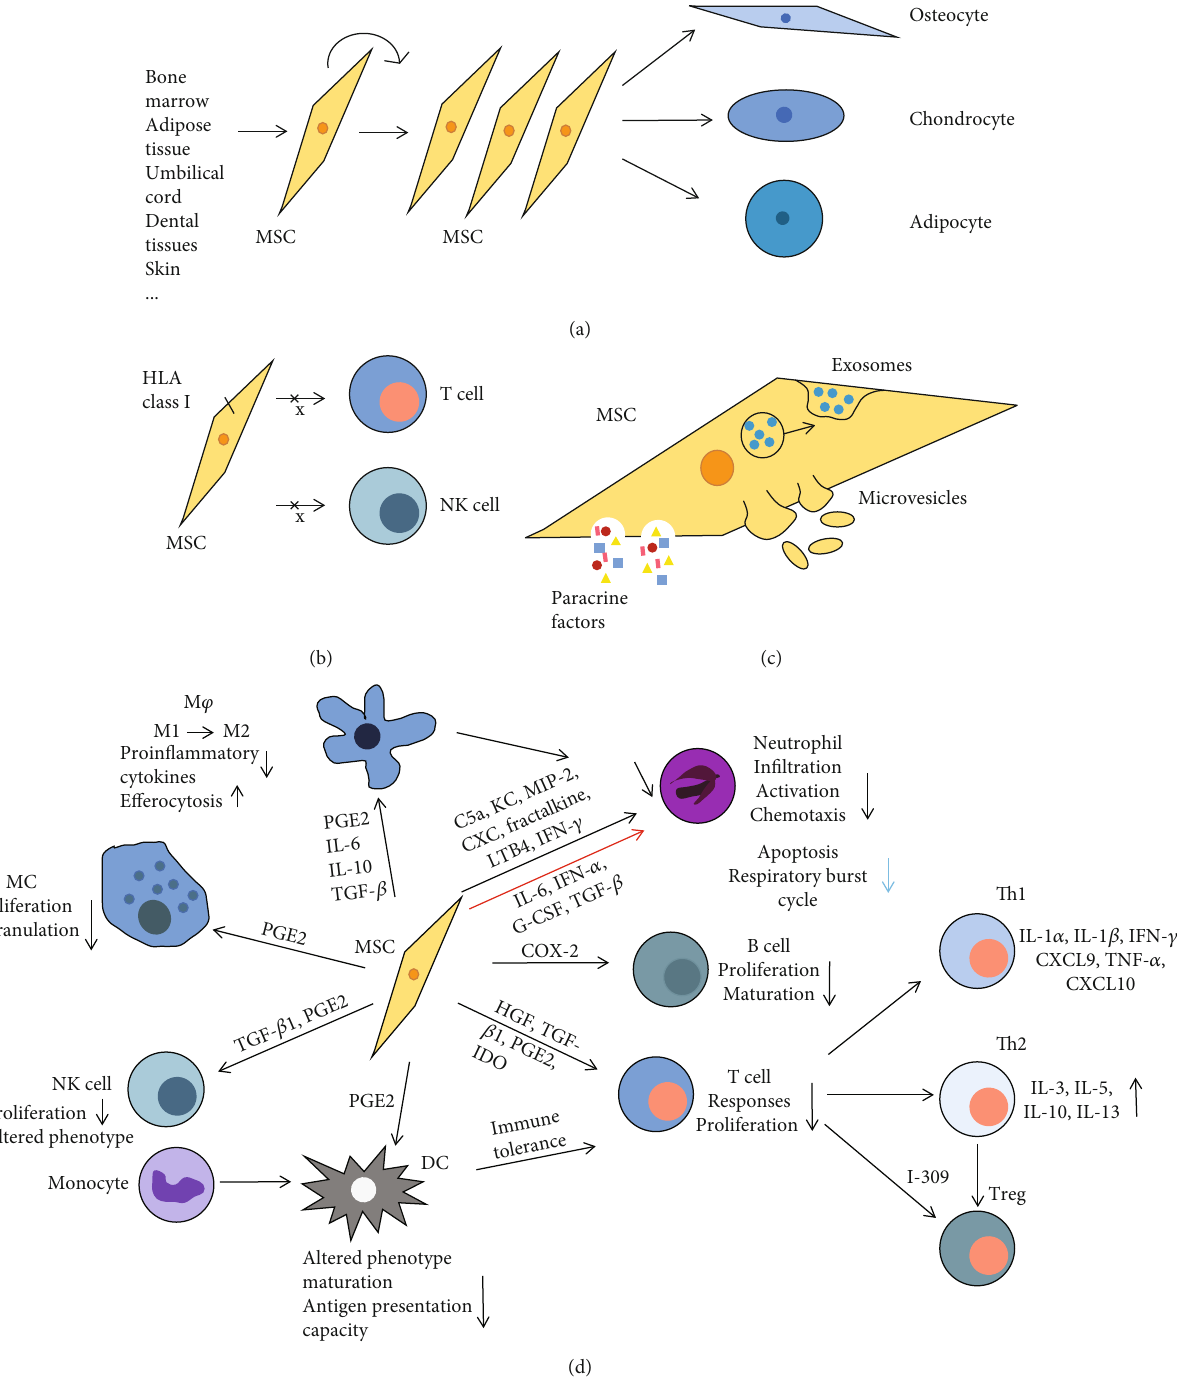
Figure 1: Schematic representation of the mechanisms of MSCs to promote tissue repair and immunosuppression. (a) Self-renewal and multipotent di ff erentiation functions. (b) Low immunogenicity. (c) Transfer of biologically active substances by paracrine or EVs. (d) Immunomodulatory